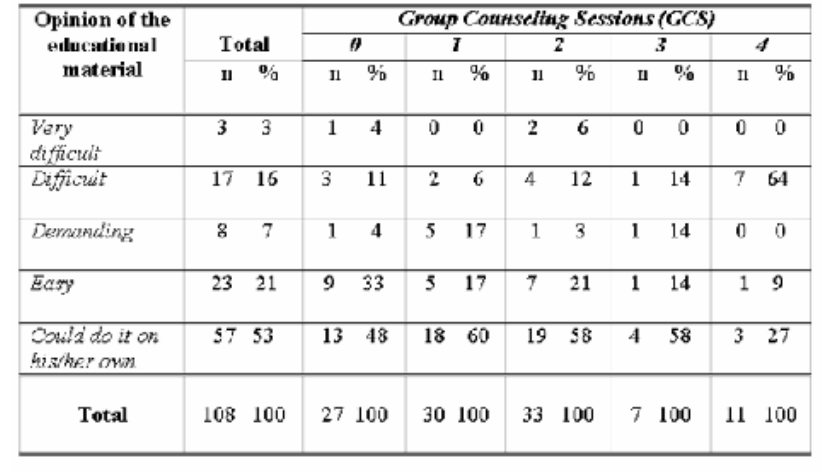
Table 10. Student dropout opinion of the educational material in terms of the group counseling sessions in which they